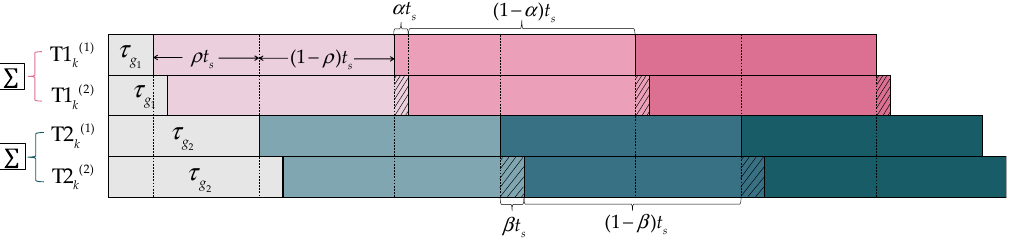
Figure 11. Asynchronous transmission process with imperfect synchronization in group.